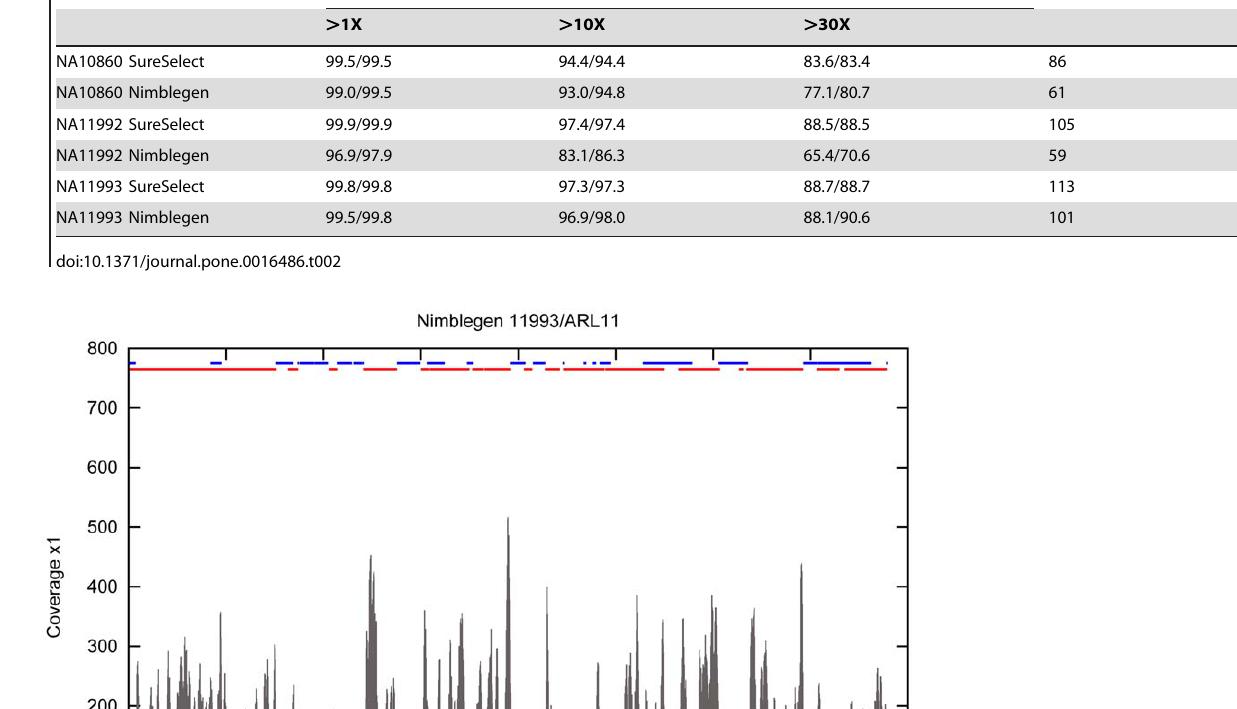
Table 2. Coverage of the probe targeted regions and regions targeted by both probe sets in each sample.